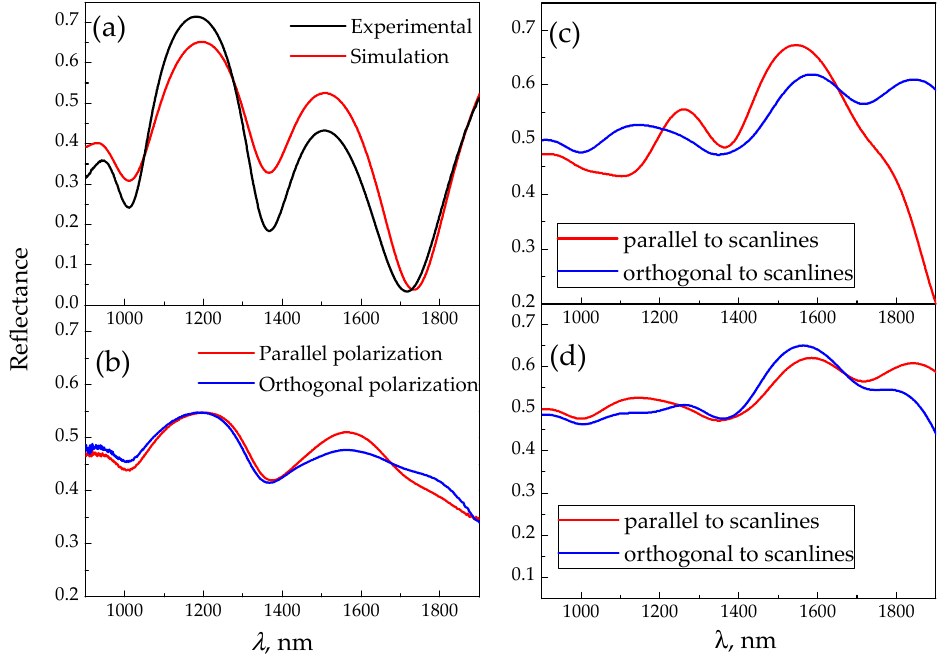
Figure 3. IR reflection spectra of as-deposited (unpolarized light) ( a ) and irradiated ( b ) GST225 samples. Calculated reflectance spectra for the scanlines considered as laminar structure caused by presence of LIPSS ( c ) and the array of nanocrystals oriented along laser radiation polarization in amorphous surrounding ( d ). The latter is characterized by a 50% volume fraction in both calculations. The ratio of ellipsoid semi-axes is equal to 10.